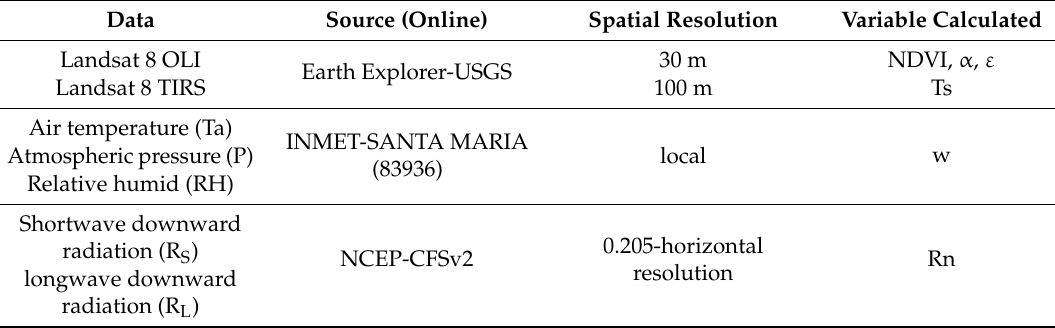
Table 1. Information of satellite and meteorological data to each variable